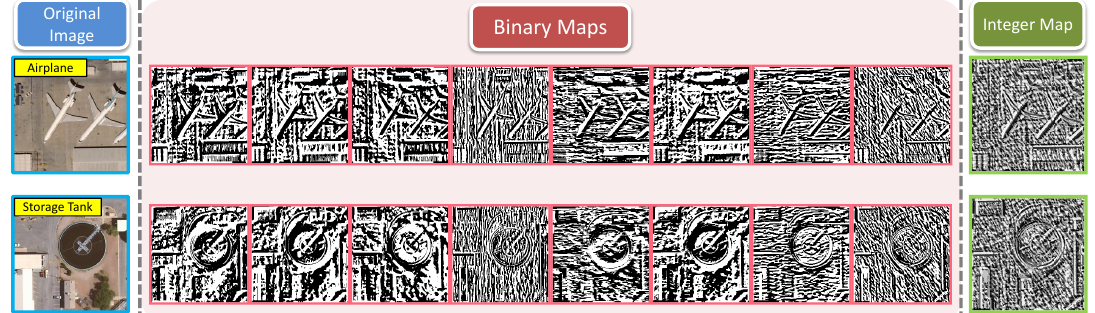
Figure 2. Illustrations of binary-valued maps and integer-valued maps. Here, we use 8 filters (of size 9 9 pixels) learned by spare coding to generate these binary maps for filter responses. The corresponding integer-valued map is generated by converting each 8-bit binary string into integer value. The integer maps contains much useful details included in original images, such as clear edges and corners. These retained details are very informative and discriminative for classification.